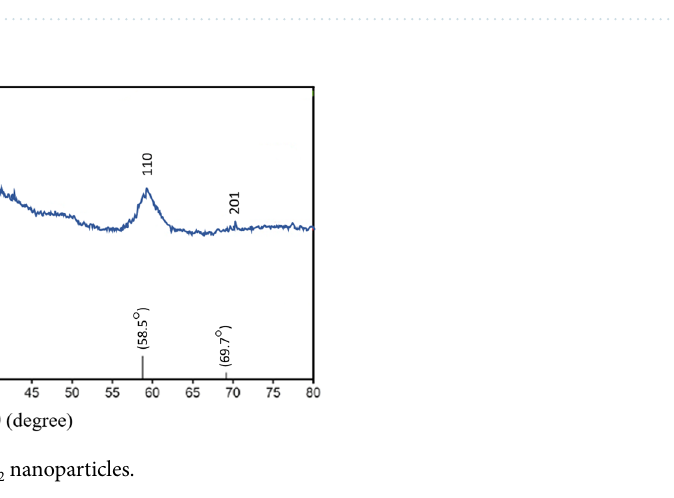
Table 1. The elemental distribution of MoS 2 nanoparticles.